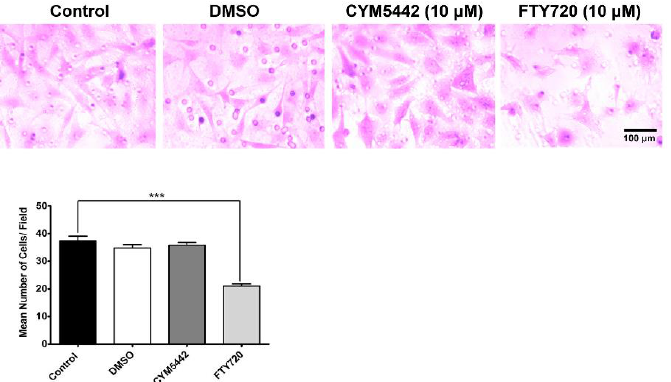
Figure 3. The S1PR agonist FTY720 inhibits ChEC migration. A suspension of ChECs was prepared in serum-free medium and added to the top of Transwell inserts and incubated for 4 h with medium containing agonist (in DMSO) or DMSO. Cells were fixed, stained with H&E, and the number of cells that migrated through the 8 μm pore size membrane was counted , as described in Methods. *** p < 0.001. ( n = 3).